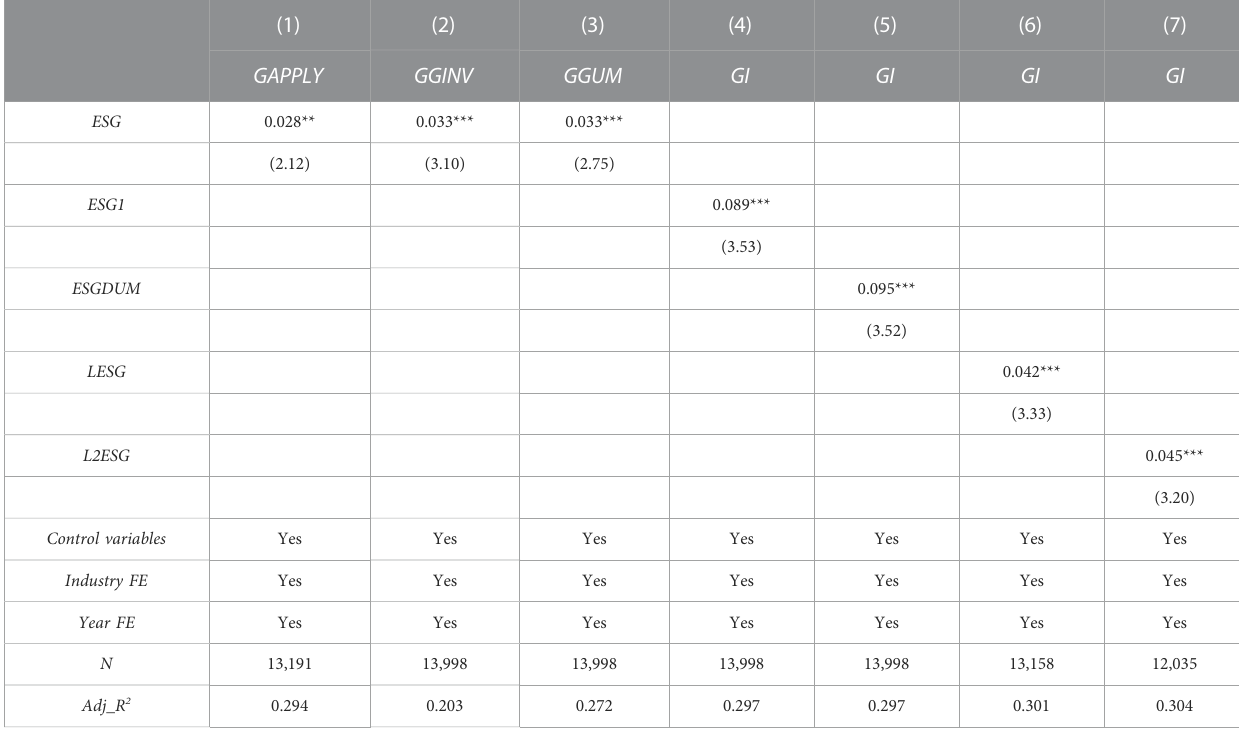
TABLE 4 Robustness tests by replacing core variable